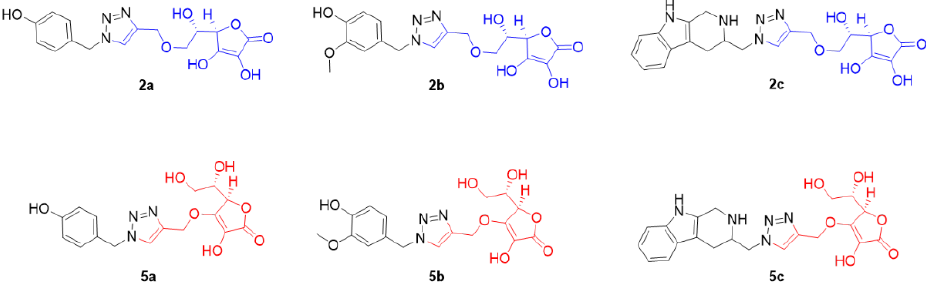
Figure 2. Structures of multifunctional novel ascorbic derivatives.